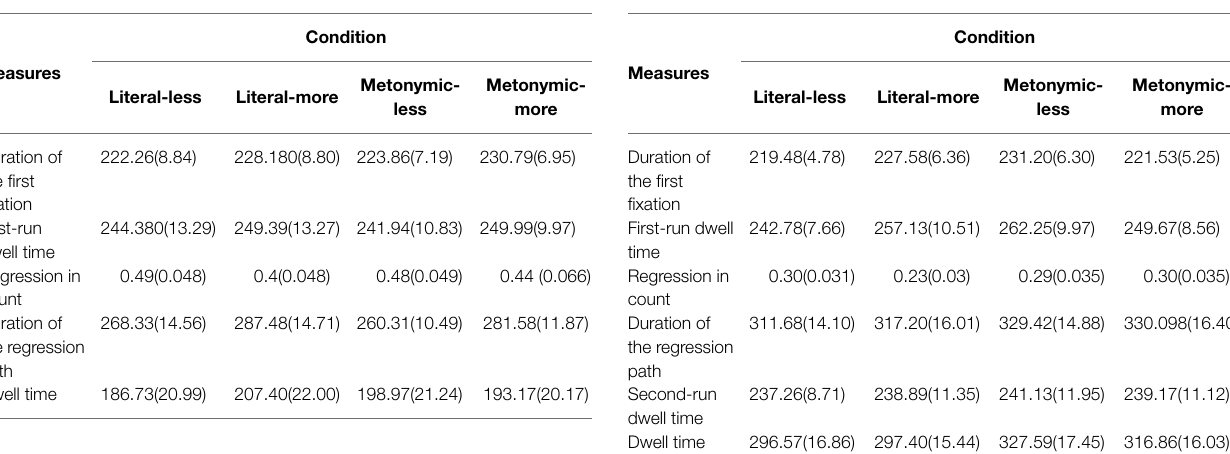
TABLE 3 | Reading times of the classifier region. TABLE 4 | Mean reading time of the spillover